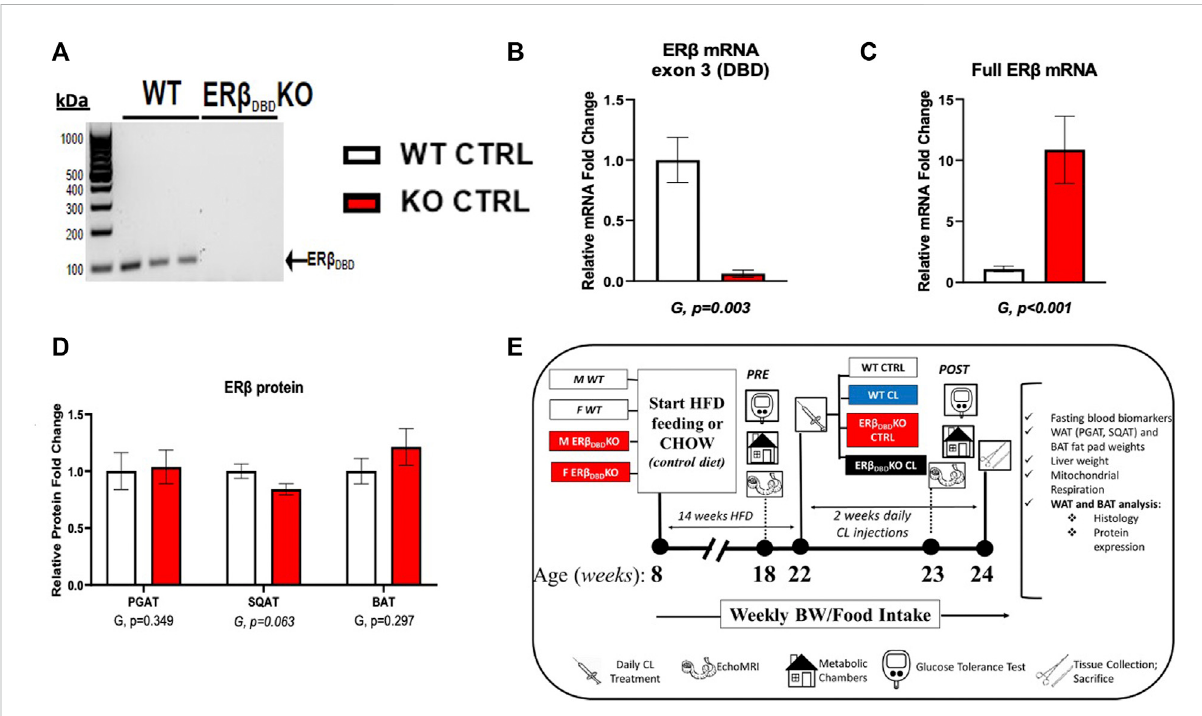
FIGURE 1 Model validation and study design. Estrogen receptor beta DNA binding domain knock-out (ER β DBD KO) mice express ER β , but lack exon3, the gene encoding the DBD. (A) Genotype validation via PCR. Forward primer (5 ′ -3 ′ ): TGTTACGTAGTCCAAGCGCCAA; reverse primer (5 ′ -3 ′ ): CATCCT TCACAGGACCAGACA. (B) Con fi rmation of lack of Esr2 DBD mRNA measured via qRT-PCR. Forward primer (5 ′ -3 ′ ): TGTTACTAGTCCAAGCGCCAA; reverse primer: CATCCTTCACAGGACCAGACA; ncbi ref seq: NM_010157.3. (C) Con fi rmation of Esr2 mRNA expression in ER β DBD KO